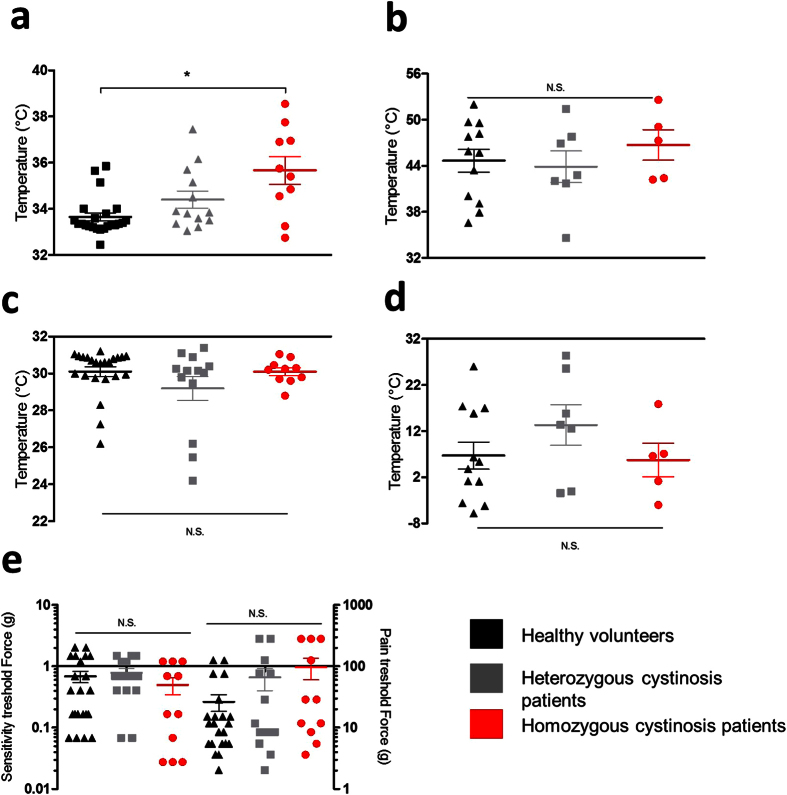
Sensitivity of cystinosis patients to thermal and mechanical stimuli.(a–d): Heat detection thresholds (a), heat pain thresholds (b), cold detection thresholds (c) and cold pain thresholds (d) in healthy volunteers, heterozygous patients and homozygous patients. (e) Detection thresholds and pain thresholds for mechanical stimuli applied via von Frey hairs in healthy volunteers, heterozygous patients and homozygous patients. *p < 0.05 between homozygous patients and healthy volunteers (Kruskall-Wallis with post-hoc Dunn’s or One-way ANOVA with post-hoc Bonferroni). N.S.: Non-significance. Data are presented as mean ± SEM.